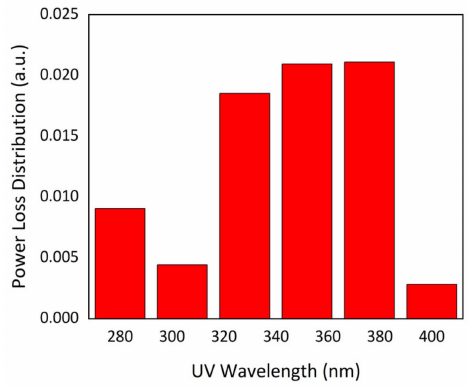
Figure 7. Calculated results from the simulated data of the electric field are presented in the power loss distribution plot for different wavelengths of incident